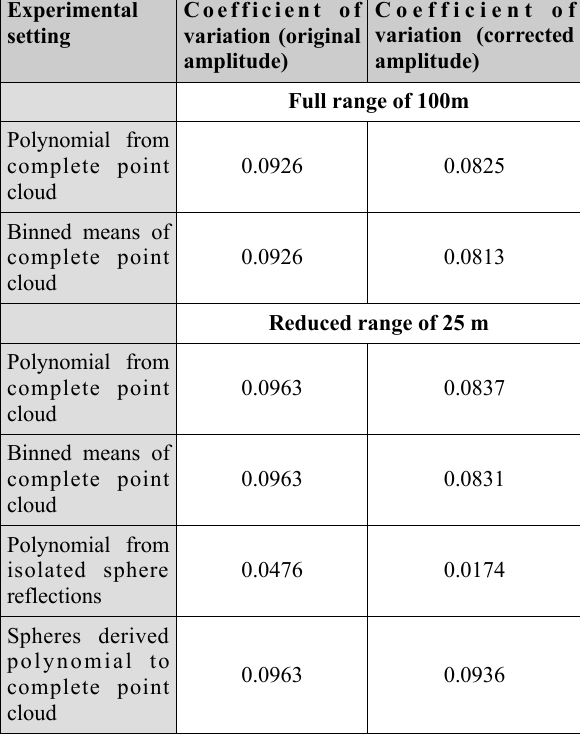
Figure 7. 3D plot of a single scan point cloud. The circular structure in the centre without points is the location of the scanner. Amplitudes are colormapped. Top: Uncorrected amplitudes with original values. Amplitudes are highly range dependent. Bottom: Amplitudes corrected by polynomial and values centred at 1000. Range dependency is largely